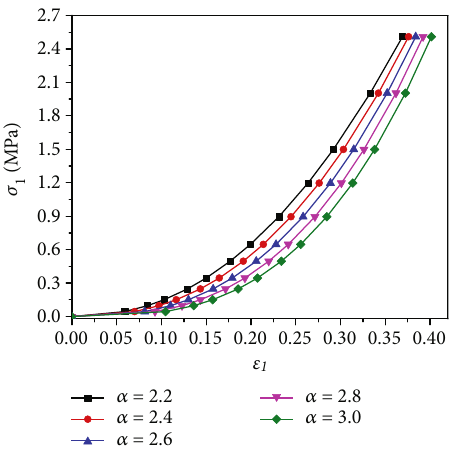
Figure 9: Sensitivity of the stress-strain curves to the elastic modulus of the voids between the broken rocks.